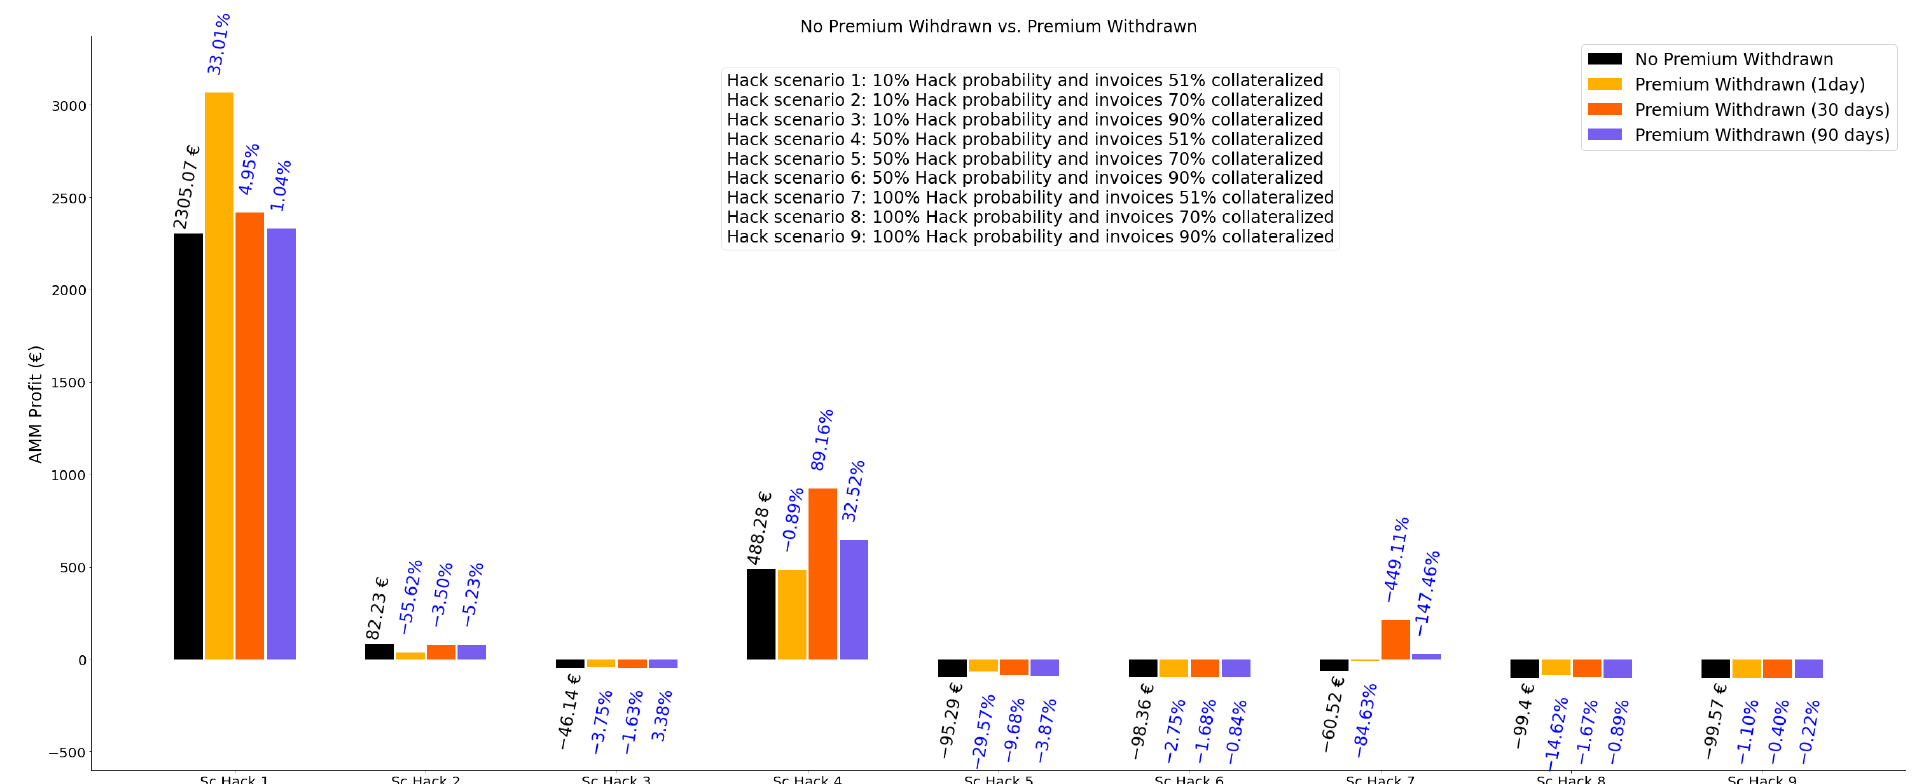
Figure 11. No Premium Withdrawn vs. Premium Withdrawn. (Hack